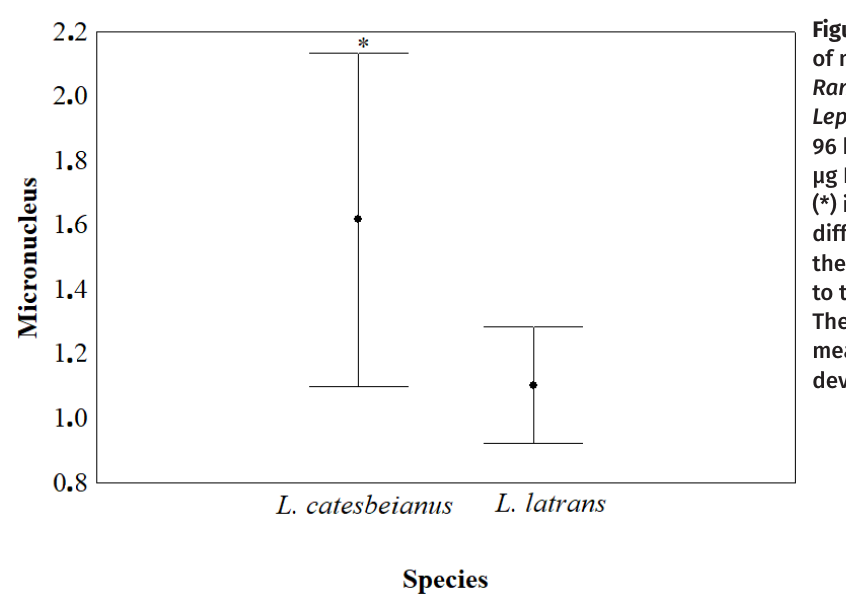
Figure 3. Mean frequency of micronuclei in Rana catesbeiana and Leptodactylus latrans after 96 hours of exposure to 50 µg L -1 of Elatus®. The asterisk (*) indicates a significant difference ( p< 0.05) between the two species according to the Student’s T test. The data are presented as mean (circles) and standard deviation (vertical